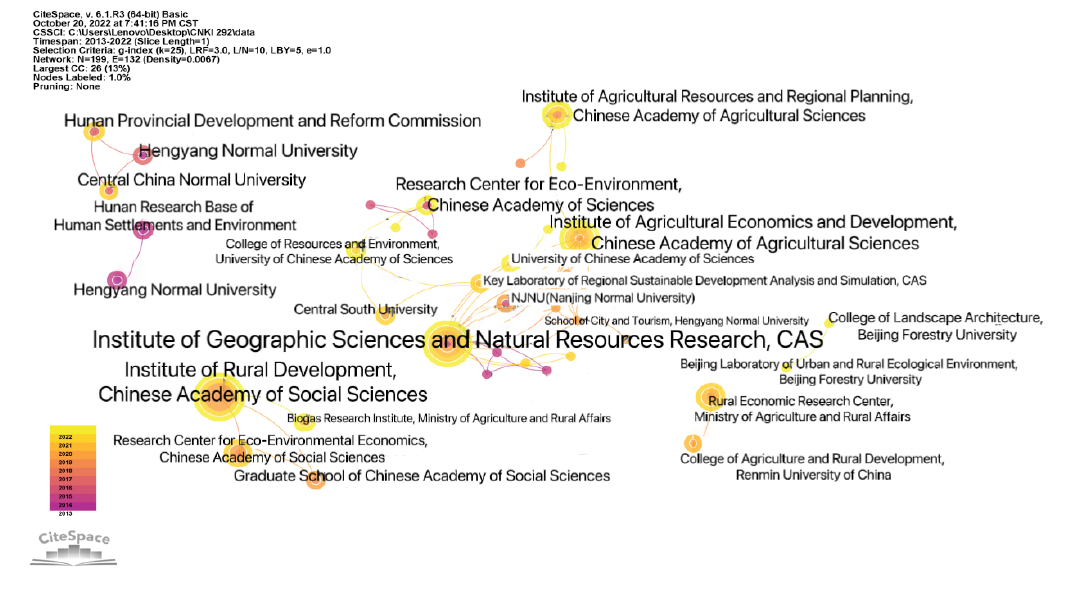
Figure 6. Knowledge map of the cooperative network of rural human settlement environment research institutions.